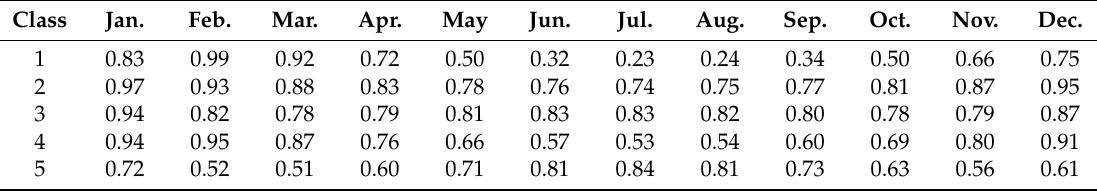
Table 3. Average relative monthly ACI values (-) for each